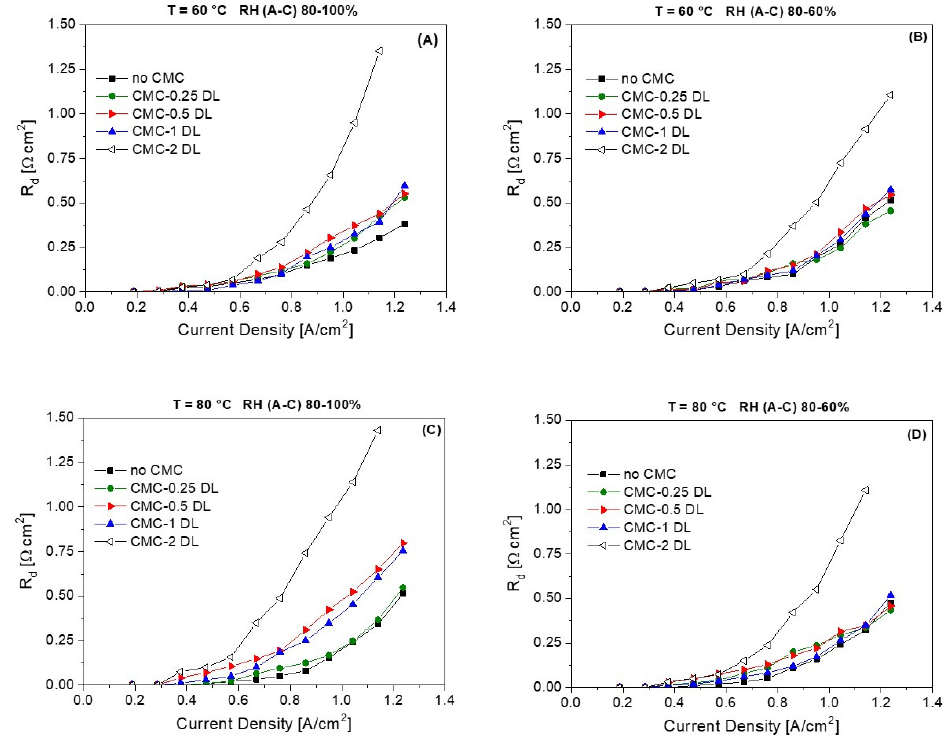
Figure 6. Diffusion resistance as a function of current density at ( A ) 60 °C and RH (A-C) 80–100%, ( B ) 60 °C and RH (A-C) 80–60%, ( C ) 80 °C and RH (A-C) 80–100%, ( D ) 80 °C and RH (A-C) 80–60%. ( B ) 60 ◦ C and RH (A-C) 80–60%, ( C ) 80 ◦ C and RH (A-C) 80–100%, ( D ) 80 ◦ C and RH (A-C)